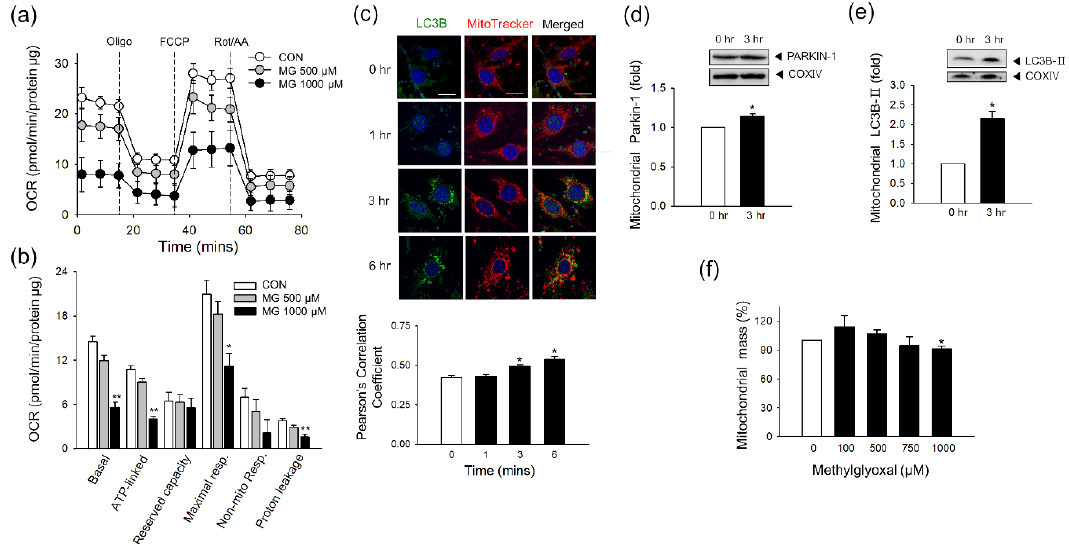
Figure 3. Mitochondrial bioenergetic disturbance and activation of mitochondrial autophagy following MG treatment in brain endothelial cells (ECs). ( a , b ) bEnd.3 cells were incubated with MG for 6 h and applied to Seahorse MitoStress Assay ( n = 3). ( a ) The profile of the oxygen consumption rate was plotted. ( b ) The parameters for mitochondrial respiration were calculated. ( c ) The localization of LC3B and mitochondria was examined at indicated times after MG treatment by confocal microscopy. Mitochondria were labeled by MitoTracker. Pearson’s correlation coefficients were calculated from three independent experiments ( n = 3). Representative images are shown. Scale bar: 20 μm. ( d , e ) The protein level of ( d ) Parkin-1 and ( e ) LC3B-II in the mitochondrial fraction was determined by western blotting. Protein levels were normalized to that of cytochrome C oxidase subunit 4 (COXIV) ( n = 3). ( f ) Mitochondrial mass was determined by staining with NAO ( n = 3). Data are presented as the mean ± SEM. * p < 0.05, ** p < 0.01 vs. control (CON).